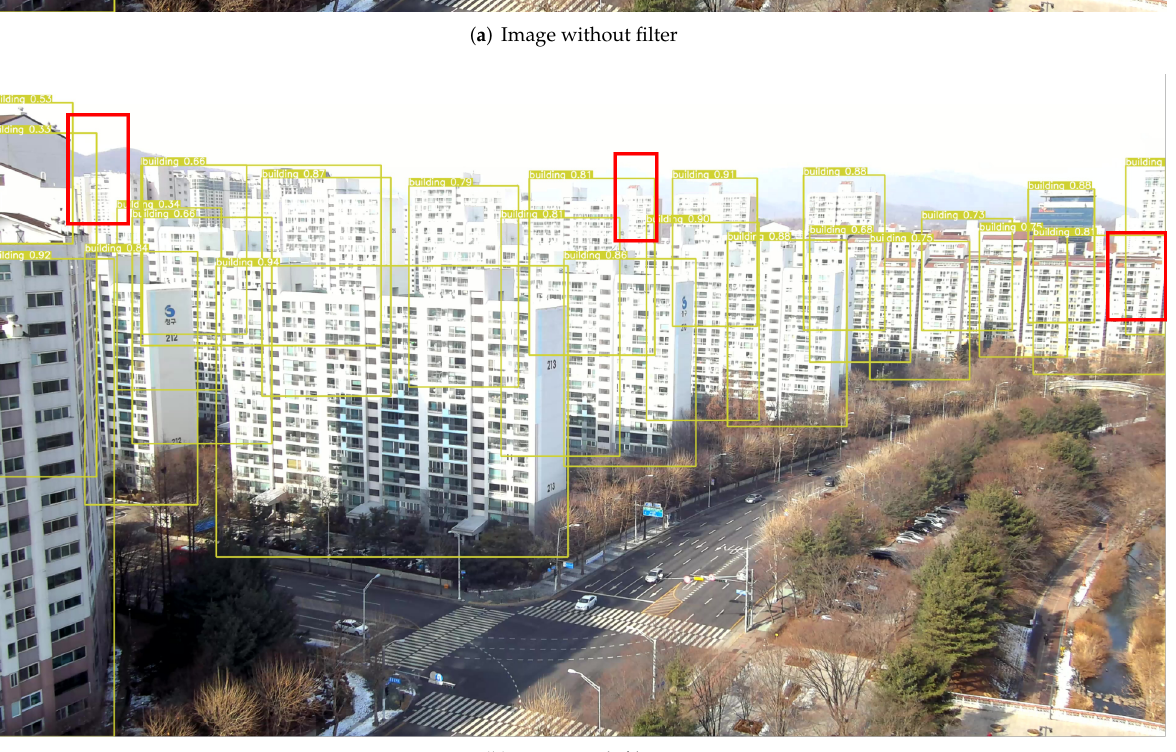
Figure 10. ( a ) Image without the filter. The buildings in the distance are also detected in this image. ( b ) Image with the filter. We used the filter to filter out the distant buildings. This is because the distant buildings do not need to be detected when creating the avoidance